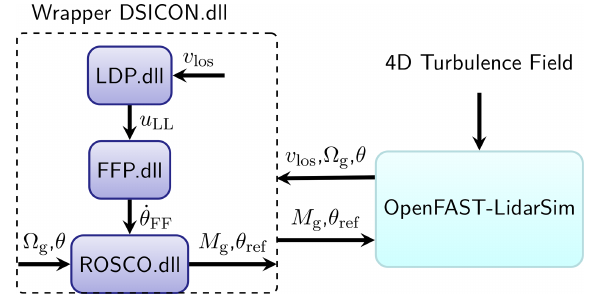
Figure 6. The overall OpenFAST and LAC interface. LDP: lidar data processing. FFP: feedforward pitch. ROSCO: the reference FB